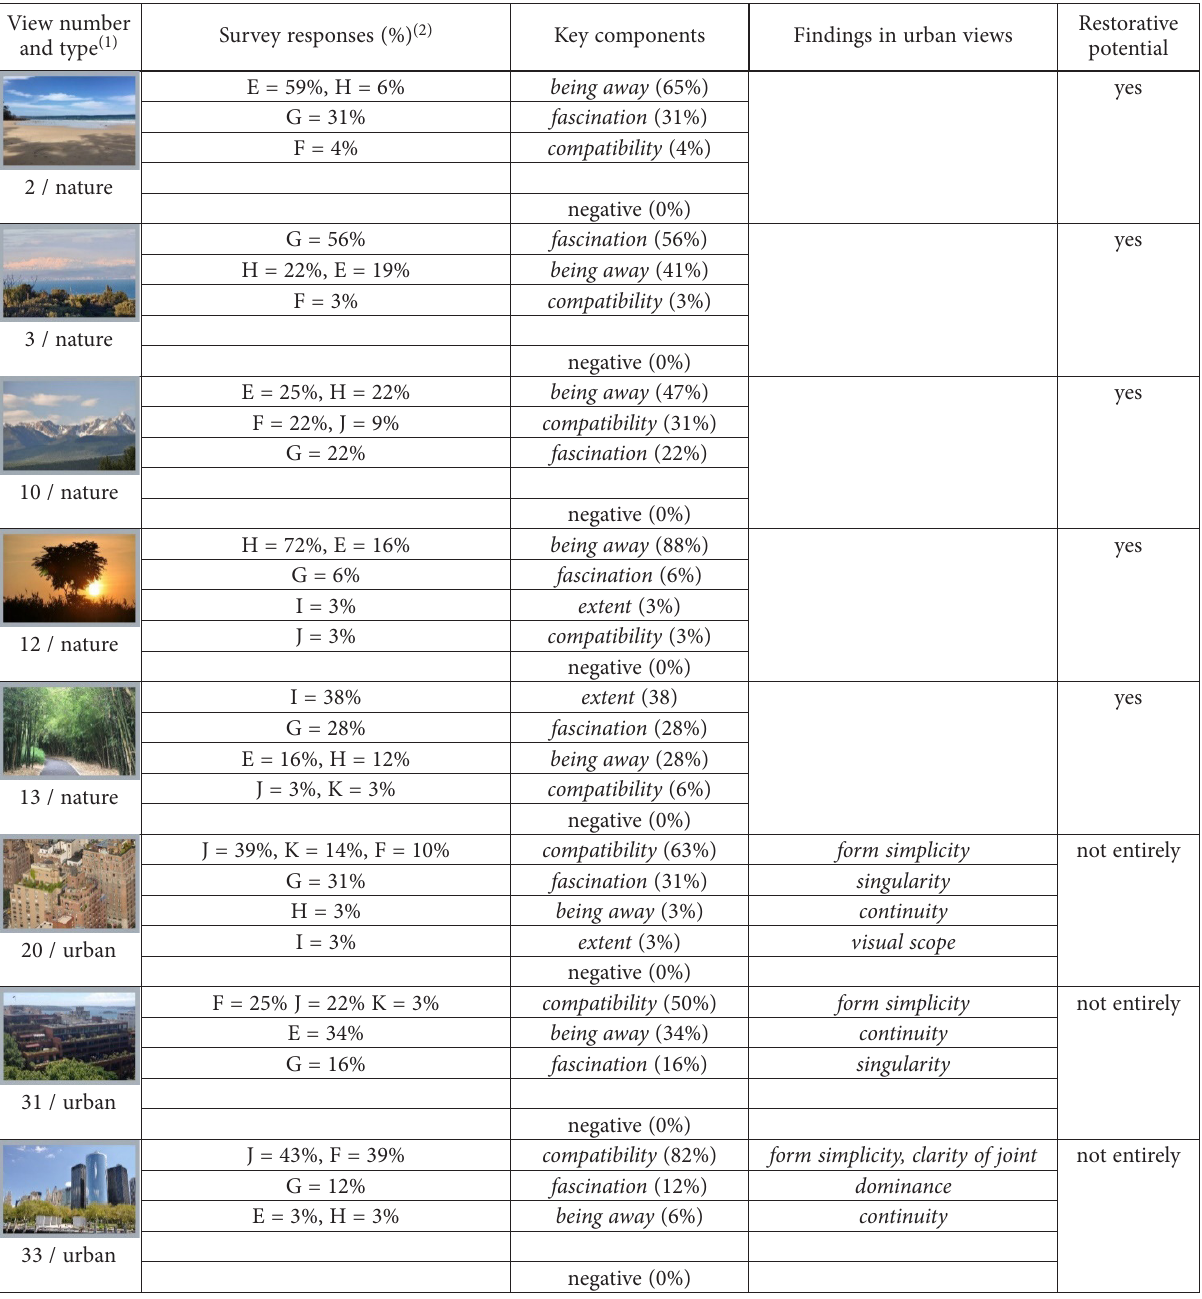
Table 1. Natural and urban window views without negative characteristics View number and type